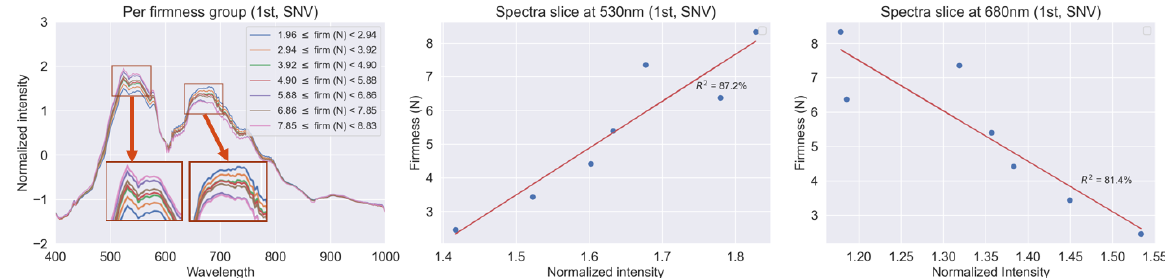
Figure 7. Average spectra of cell walls among different firmness; two plots on the right side show a linear relationship between firmness and average intensity normalized with SNV at each peak wavelength (530 nm and 680 nm).